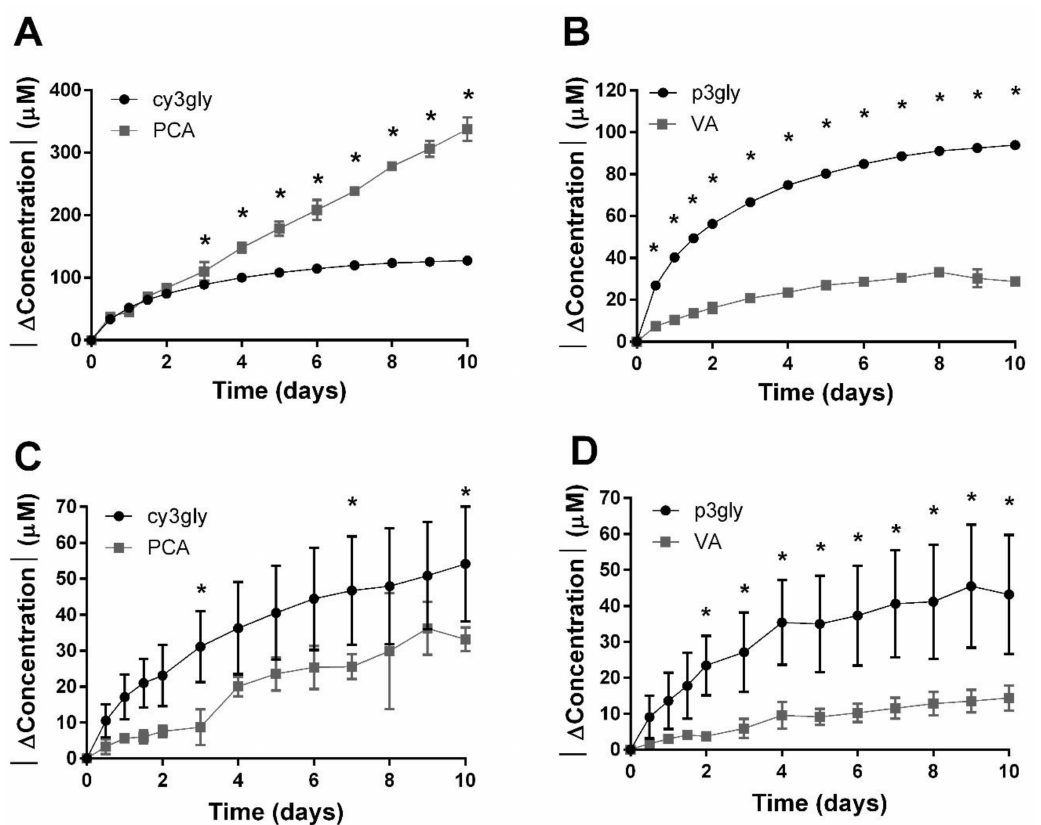
Figure 1. Accelerated aging of cranberry juice or isolated anthocyanins at 50 ◦ C alters soluble anthocyanins and hydrox- ybenzoic acids. Data are the absolute value of concentration change from Time 0, as the means ± standard deviations. ( A ) Cyanidin 3- O -glycosides (cy3gly) and protocatechuic acid (PCA) in whole juice. ( B ) Peonidin 3- O -glycosides (p3gly) and vanillic acid (VA) in whole juice. ( C ) Cy3gly and PCA in anthocyanin isolate. ( D ) P3gly and VA in anthocyanin isolate. Cy3gly is the sum of cyanidin 3- O -galactoside, cyanidin 3- O -glucoside, and cyanidin 3- O -arabinoside, while p3gly is the sum of peonidin 3- O -galactoside, peonidin 3- O -glucoside, peonidin 3- O -arabinoside. For those time points indicated (*), the change in total anthocyanin concentration and change in corresponding hydroxybenzoic acid concentration are statistically different according to two-way ANOVA with Sidak’s multiple comparisons test, where p < 0.05. For ( A , B ), p < 0.0001 for Time, ∆ Concentration, and their interaction; for ( C ), p < 0.001 for Time, p = 0.0318 for ∆ Concentration, and p = 0.0038 for their interaction; and for ( D ), p < 0.0001 for Time, p = 0.0097 for ∆ Concentration, and p < 0.0001 for their